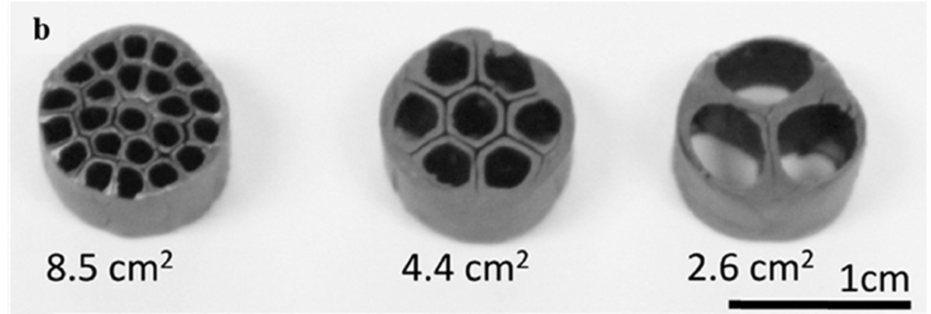
Figure 8. Polymer-based coextrusion ceramic honeycombs made from homogeneous composites of iron oxide and zirconia for the solar thermochemical dissociation of CO 2 to CO [142]. Furler et al. [150] examined porous ceria felt for thermochemical CO 2 and water splitting in a solar directly irradiated cavity-receiver, exposed to a mean solar concentration ratio of 2865 suns (TR: 1527 ◦ C and WS/CDS: 827 ◦ C). The dependence of the